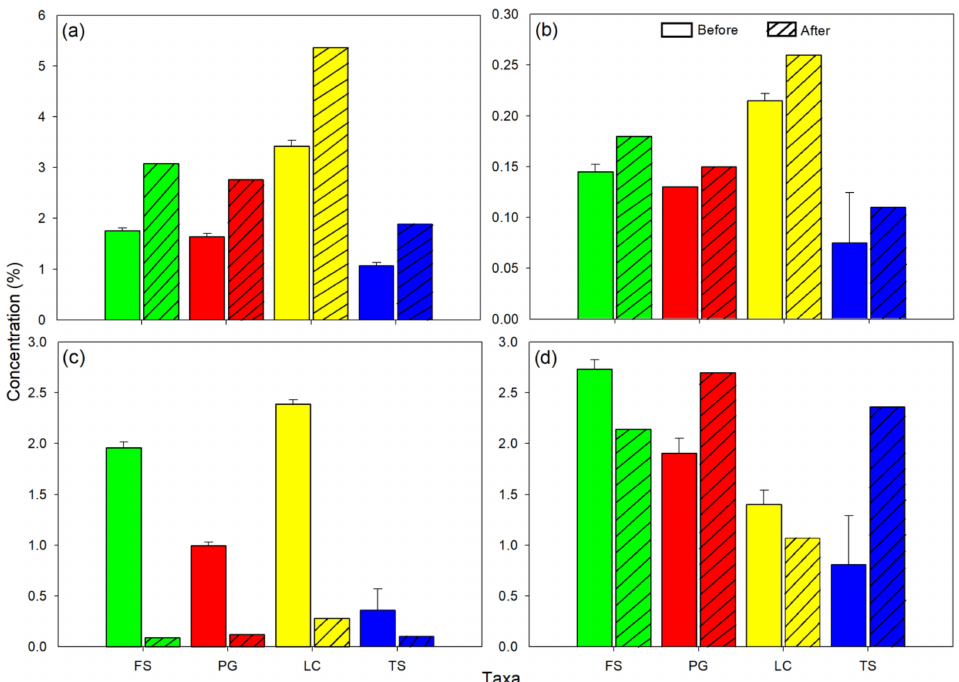
Figure 3. Leaf nutrient concentrations ( + standard deviation) of invasive L. camara (yellow) and P. guajava (red), and native T. sericea (blue) and F. sycomorus (green), before and after the experiment: ( a ) total N, ( b ) total P, ( c ) K, and ( d ) Ca.